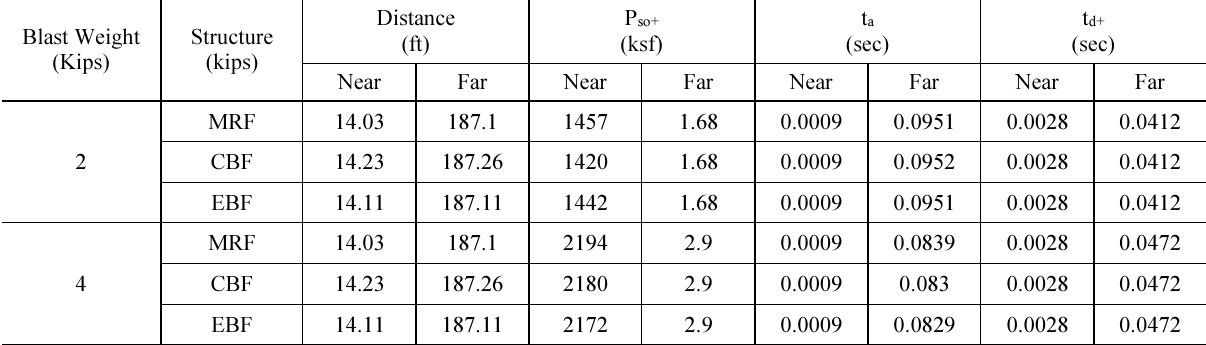
Table 5. Specific blast parameters for the near and far point for MRF, CBF and EBF (1 kips = 4.45 kN, 1 ft = 0.31 m, 1 ksf = 48 kPa) Blast